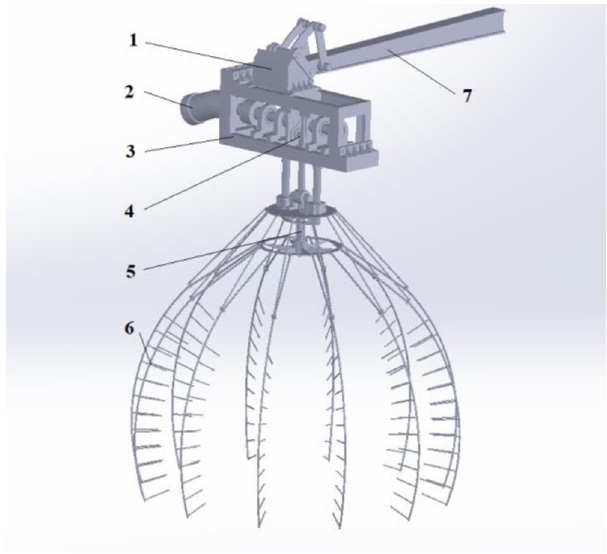
Fig. 1. Structure diagram of picking machine.